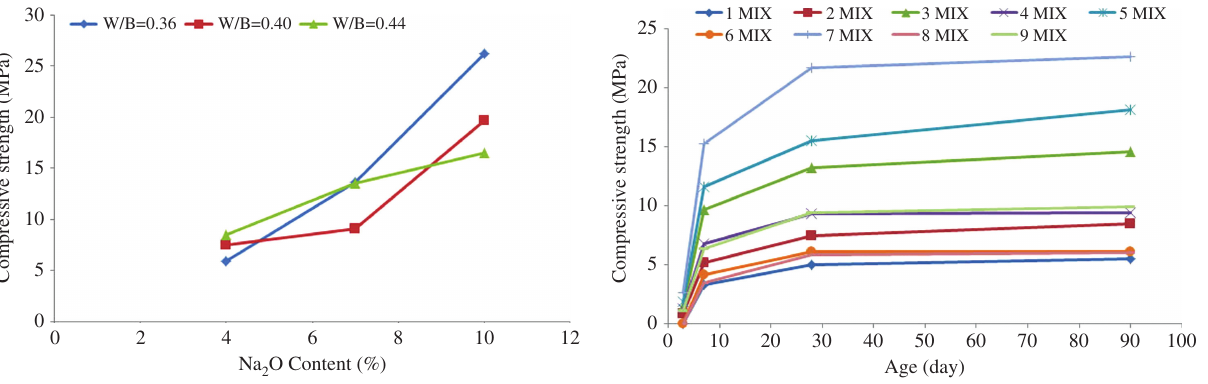
Figure 13 The effect of aging on geopolymer compressive strength for samples cured at 25 ° C.